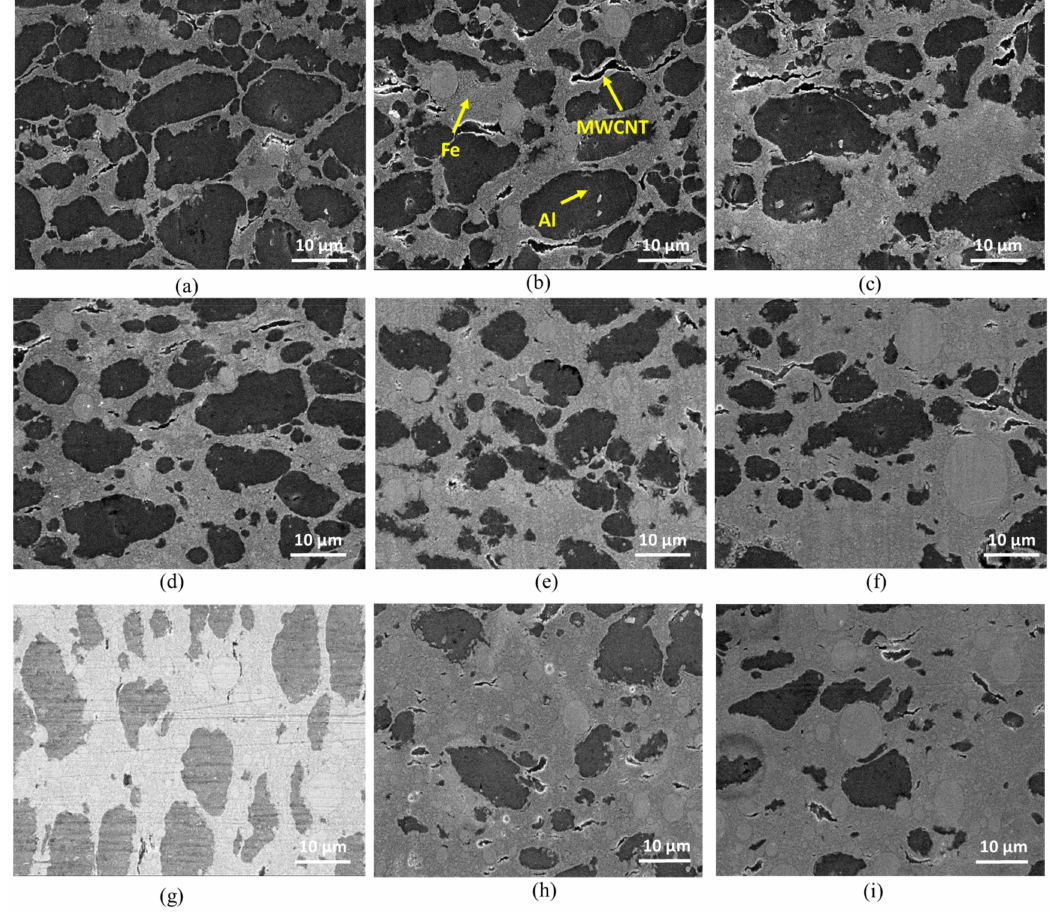
Figure 2. SEM images of Fe-Al-MWCNT hybrid nanocomposites: ( a ) 33Fe-65Al-2MWCNT (M1); ( b ) 38Fe-60Al-2MWCNT (M2); ( c ) 43Fe-55Al-2MWCNT (M3); ( d ) 48Fe-50Al-2MWCNT (M4); ( e ) 50Fe-48Al-2MWCNT (M5); ( f ) 55Fe-43Al-2MWCNT (M6); ( g ) 60Fe-38Al-2MWCNT (M7); ( h ) 65Fe-33Al-2MWCNT (M8); and ( i ) 70Fe-28Al-2MWCNT